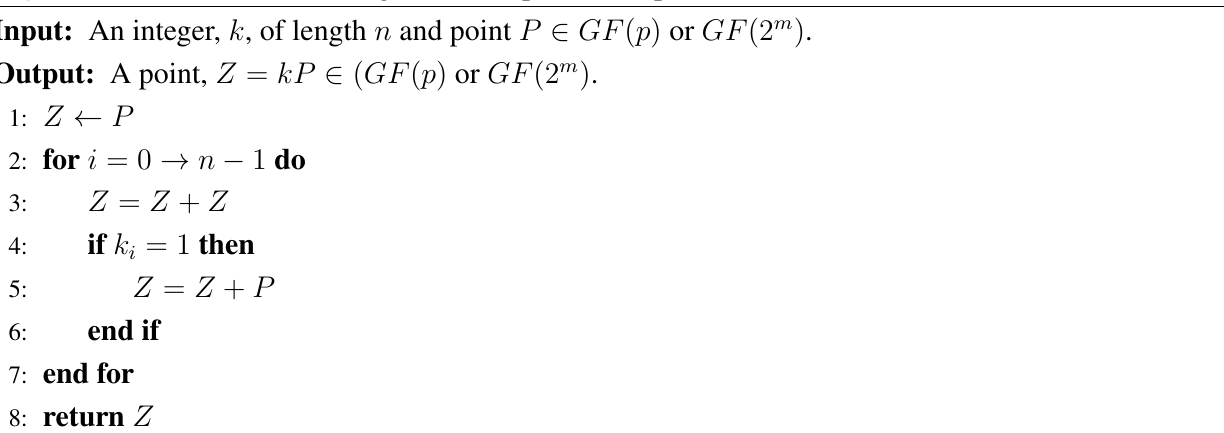
Algorithm 8 Double-and-add algorithm for point multiplication.